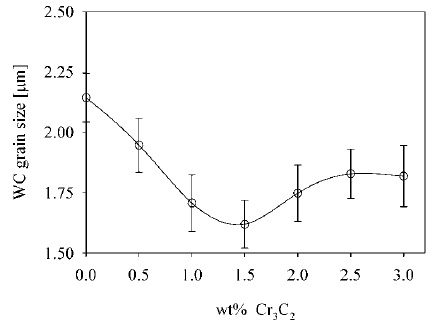
Figure 2. Effect of the Cr 3 C 2 addition on the WC grain size of the WC-10Co cemented carbide.